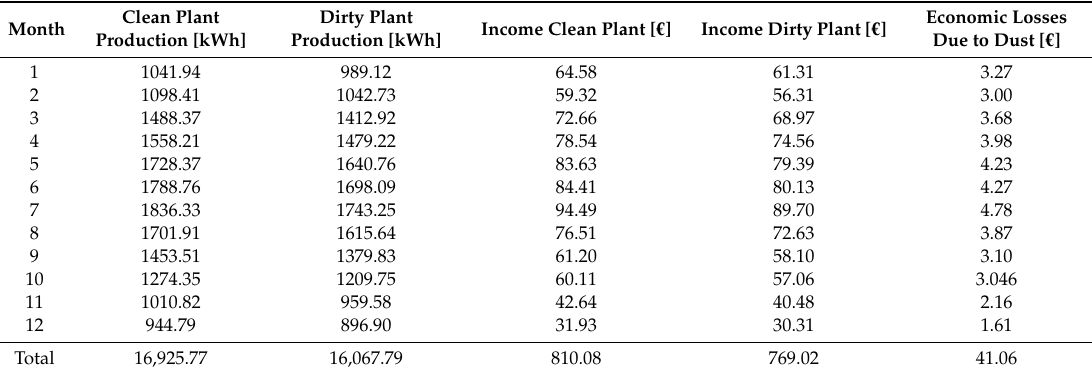
Table 5. CIESOL plant income (9 kWp), clean and dirty.